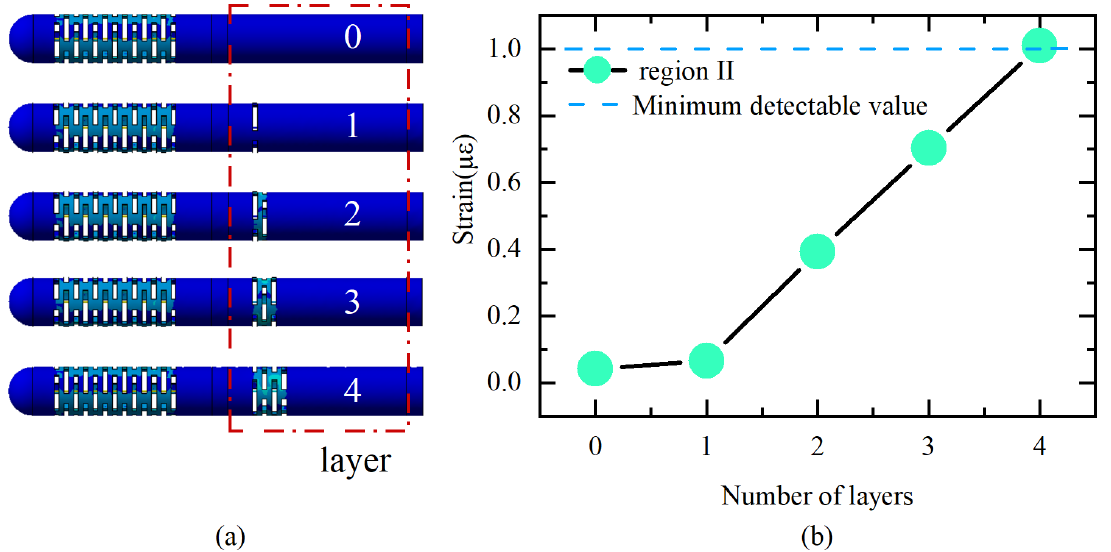
Figure 3. ( a ) Different structures; ( b ) strain of FBG2 under axial force of 0.01 N with different structures. A force within 0–2 N is applied to the flexure along the axial direction in the steps of 0.5 N. The strain distribution of the fiber along the axial direction under force stimulation and the relation between the applied force and the strain distribution along the fiber in the direction of the applied force are shown in Figure 4. It can be observed that there is a clear strain difference between the fiber in the I and II regions when subjected to the same force, and the strains in both suspended sections of the fiber are very stable due to the two-point adhesive method, which ensures the stable measurement of the FBG wavelength shift. The strain in the remaining part of the fiber is small and almost zero because the rest of the fiber is in the gluing region and is fixed in the hole slot. The feasibility is further